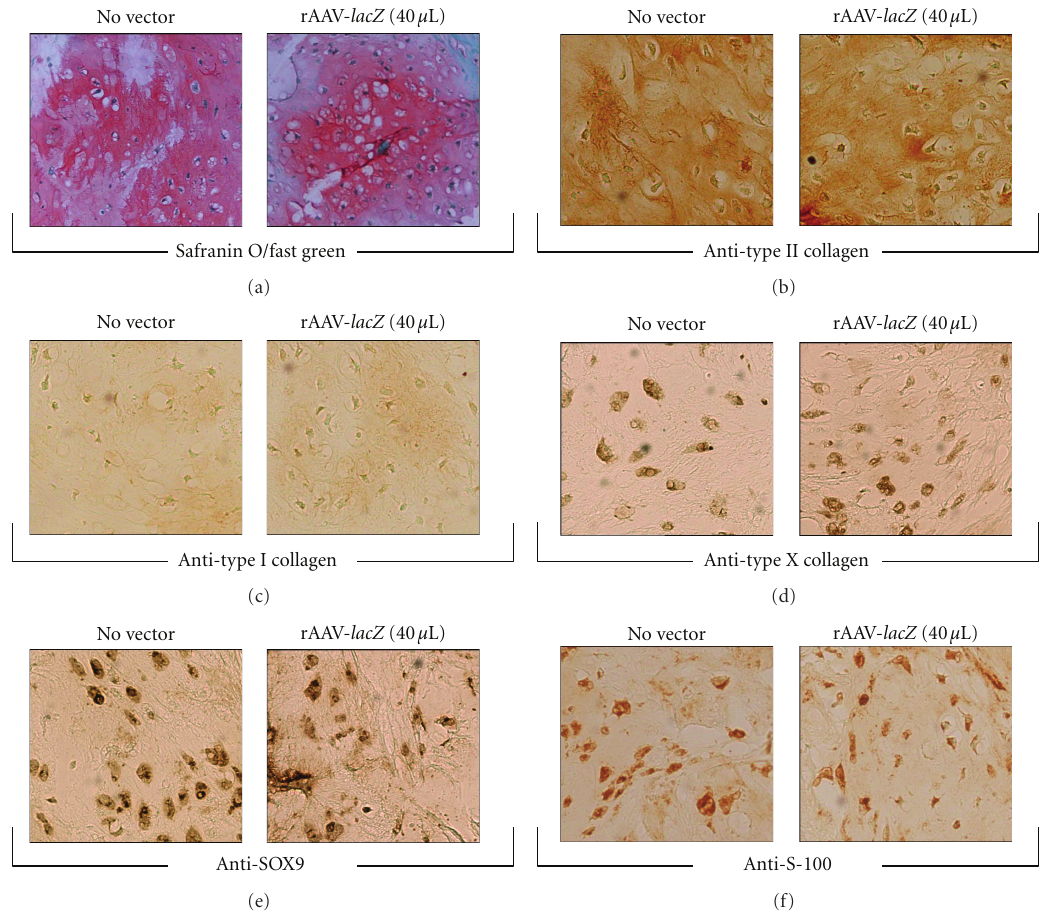
Figure 5: E ff ects of rAAV-mediated gene transfer on matrix accumulation and chondrogenic cell di ff erentiation marker expression in transduced primary human chondrosarcoma in situ . Human chondrosarcoma explant cultures were transduced as described in Figure 4 and processed after 20 days for safranin O staining (a) and for immunodetection of type II collagen (b), type I collagen (c), type X collagen (d), SOX9 (e), and S-100 (f). All at magnification × 20 except for safranin O staining (magnification × 10).